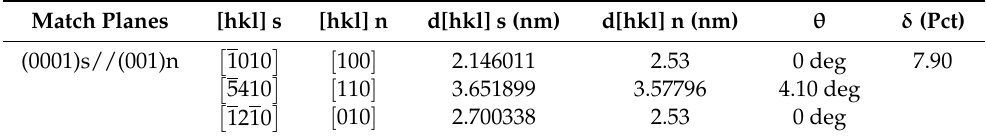
Table 3. Planar disregistries between α -Al 2 CaSi 2 and α -AlFeSi. s is for Al 2 CaSi 2 and n is for α -AlFeSi. Match